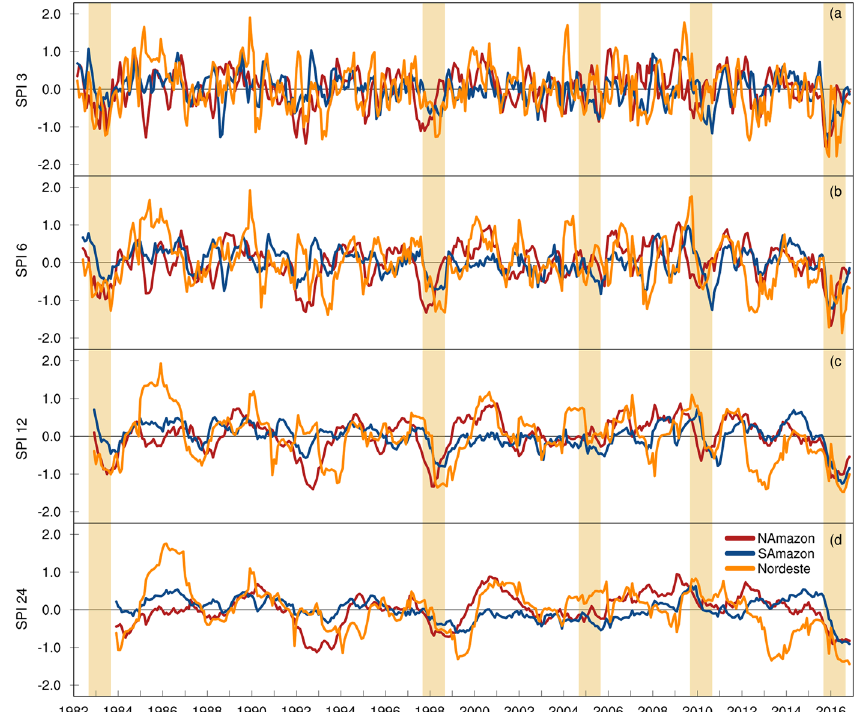
Figure 1. Time series of Standardized Precipitation Index (SPI). The entire Tropical/sub-Tropical South America is divided into South Amazon (SA), North Amazon (NA), and Nordeste (NORD) regions to construct the area-averaged time series (see Figure S1 for details). The 3, 6, 12, and 24-month SPIs shown in ( a , b , c and d ) respectively were calculated using the GPCC monthly precipitation data from 1982 to 2017. For all time scales, the 2016 SPIs over Nordeste and South Amazon are the largest seen in the analysis period. Figures created with: The NCAR Command Language (Version 6.3.0) [Software]. (2016). Boulder, Colorado: UCAR/NCAR/CISL/ TDD.